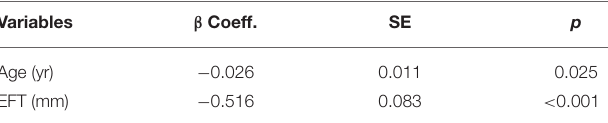
Variables β Coeff.